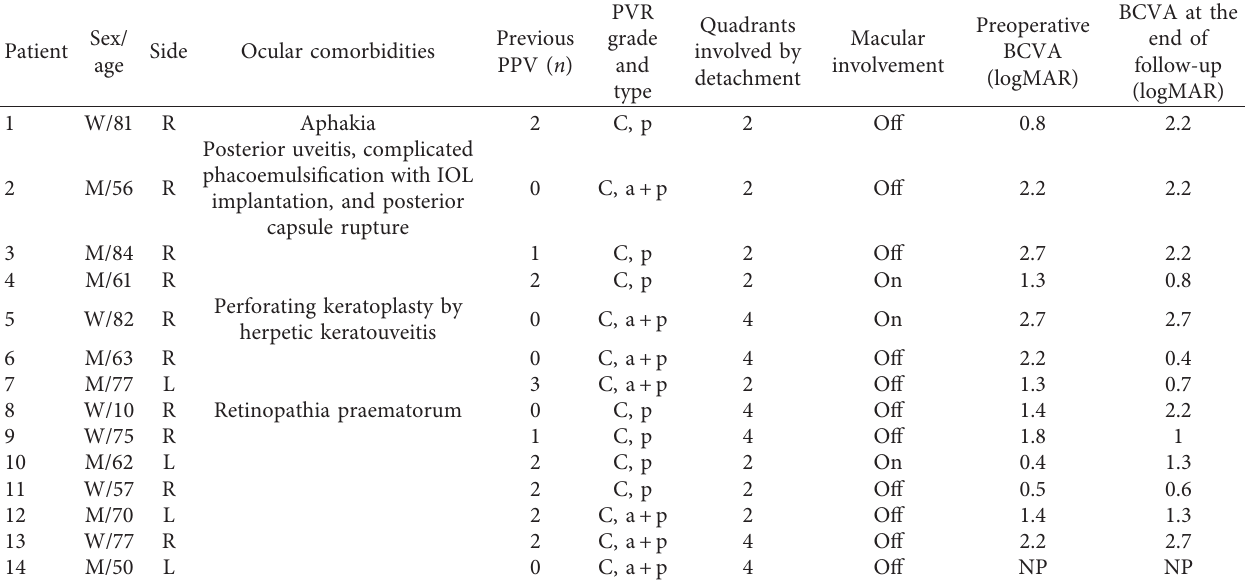
Table 2: General data of